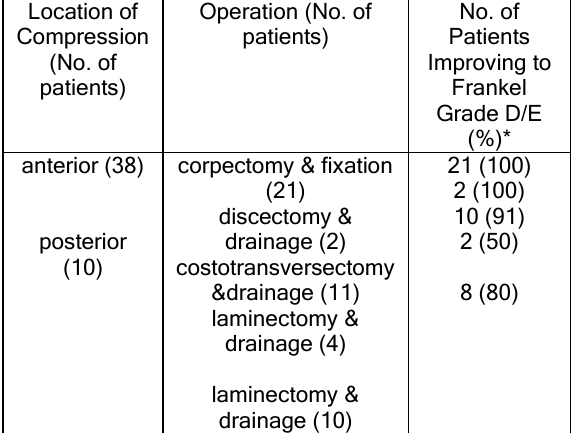
Table 3. Correlation of the final Frankel grade with the location of compression and the operative procedure Location